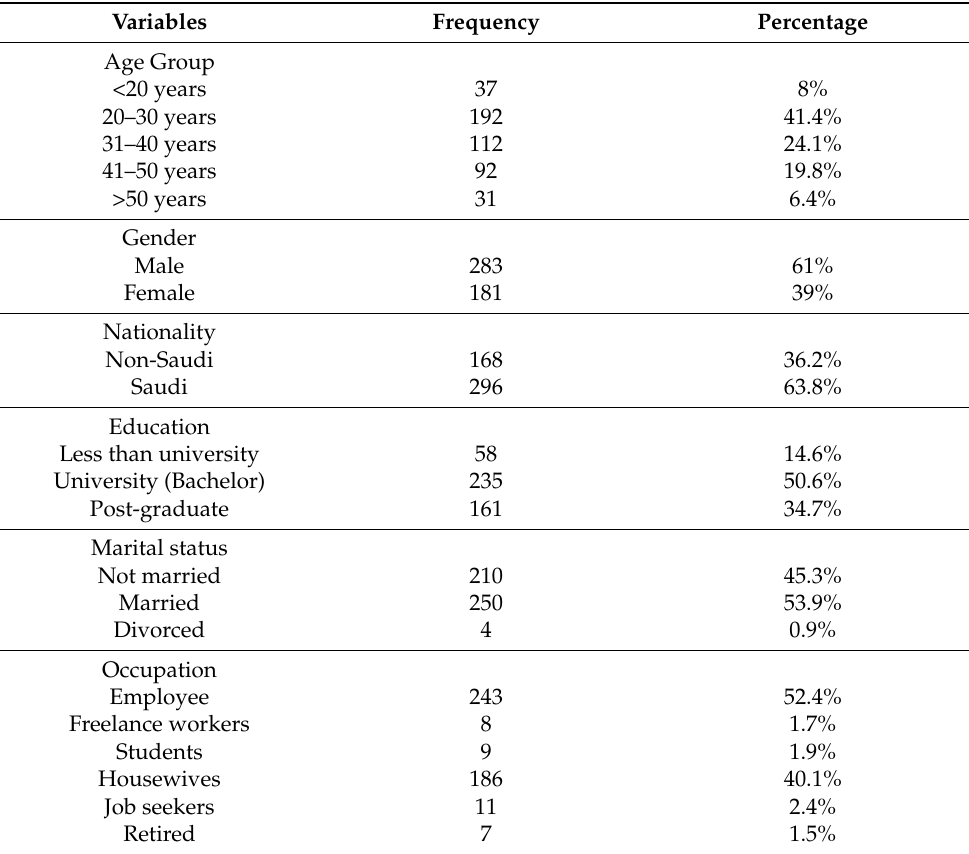
Table 1. Demographic characteristics of the study